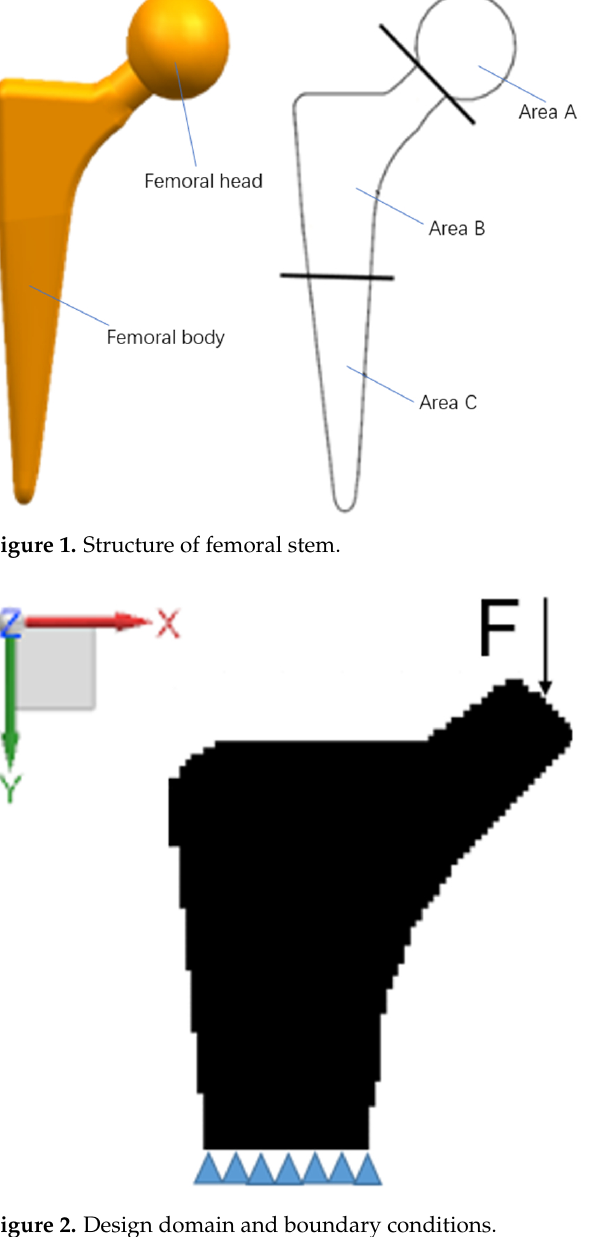
Figure 2. Design domain and boundary